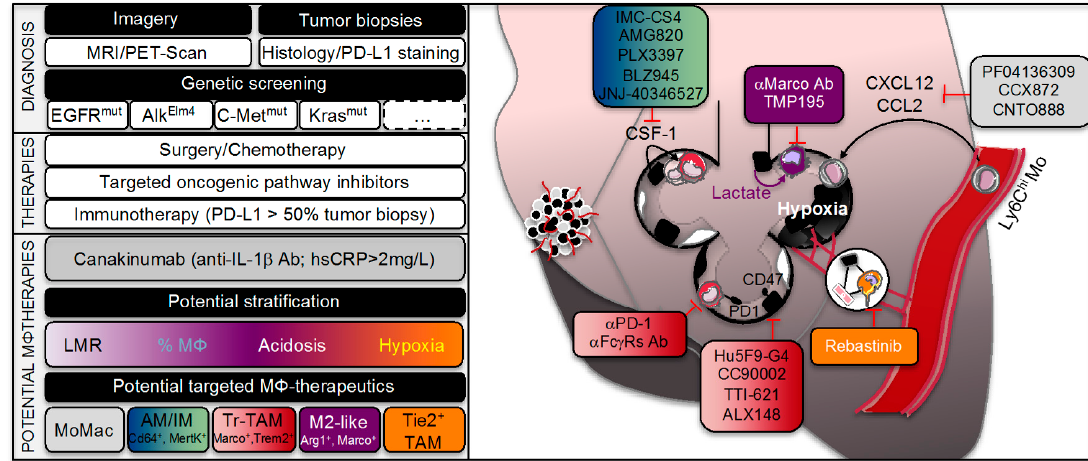
Figure 3. Lung adenocarcinoma treatment and emerging therapeutic potential of targeting macrophages. Diagnosis of lung adenocarcinoma patient requires at first magnetic resonance imaging (MRI) or positron-emission tomography scan (PET-scan). Tumor biopsies were also performed to further characterize the histology of the tumor and to determine the cancer cell’s origin, the disease progression, and the expression of PD-L1 among other features. Oncogenic mutations driving lung adenocarcinomas were screened, of which V-KI-ras2 Kirsten rat sarcoma viral oncogene homolog (KRAS) and epidermal growth factor receptor (EGFR) mutations were the most frequent. These different diagnoses allow personalized treatment options with targeted oncogenic pathway inhibitors and/or chemotherapy. Immunotherapy is highly patient-dependent since the treatment with a checkpoint inhibitor that targets the PD-1/PD-L1 pathway requires tumors expressing levels of PD-L1 higher than 50%. These therapies are generally not exclusive and different strategies are employed for a better healing without remission. Novel potential therapies are aimed at targeting tumor-associated macrophages (TAMs). Whether or not IL-1 β inhibitory antibody (Canakinumab) targets macrophages, its use on patients with C-reactive protein (CRP) levels higher than 2 mg/L reduced the rate of lung cancer. Composition of the tumor microenvironment (TME) may allow patient stratification. For instance, lymphocyte-monocyte ratio (LMR), a prognostic factor and a predictor survival, could be modified with CCR2 inhibitors (PF04136309 or CCX872) or with CCL2 inhibitors (CNTO888), preventing the recruitment of circulating Ly6C hi monocytes into tumors. To limit the conversion of tissue-resident macrophages (i.e., alveolar macrophages AMs and interstitial macrophages IMs) into TAMs, blocking antibodies anti-CSF-1R (IMC-CS4 or AMG820) and tyrosine kinase inhibitors (PLX3397, BLZ945 or JNJ-40346527) are used. Cancer cells express CD47 on their surface, known to be a “don’t eat me” signal and recognized by SIRP1 α expressed on macrophages, which triggers a cascade of events that inhibit phagocytosis: anti-CD47 (Hu5F9-G4 or CC90002) or competitive recombinant SIRP1 α FC (TTI-621 or ALX148) are developed as a way to reeducate TAMs for eliminating cancer cells. As for T-cells, TAMs also express the immune checkpoint receptor PD-1, inducing immune tolerance and TAMs PD-1 expression reduced the phagocytic potency against tumor cells. Immunotherapy with the use of α PD-1 not only targets PD-1/PD-L1 pathway on T-cells but is efficient to reactivate phagocytic potency of macrophages. However, TAMs could limit anti-PD-1 therapeutic benefits by stealing and capturing α PD-1 antibody from the CD8+ T-cells via Fc γ RIIb/III receptors unless if α Fc γ Rs antibodies are administrated before. Another way to reeducate TAMs is to convert M2-like macrophages to an antitumor phenotype in targeting MARCO ( α Marco Ab) or in inhibiting histone deacetylase (TMP195) to reprogram macrophage-dependent T-cell immune responses. Rebastinib reduced cancer cell metastasis by inhibiting a specific Tie2 + TAMs population implicated in the angiogenic